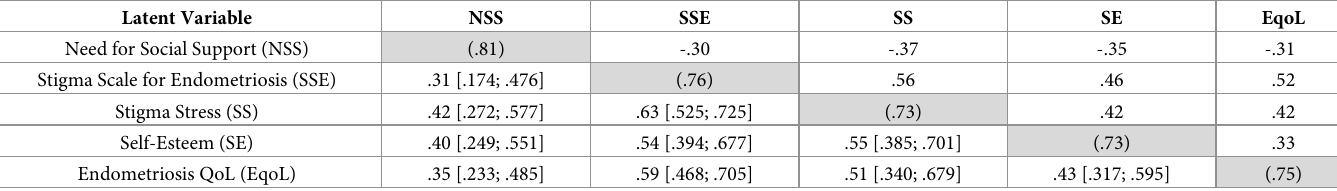
Table 3. Correlation matrix of latent variables using the fornell-larcker criterion and correlation proportion of heterotrait-monotrait (HTMT).